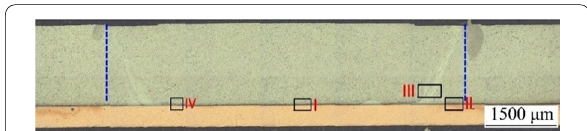
Figure 5 ( a ) SEM image of region II in Figure 3, and element maps for ( b ) Al and ( c )